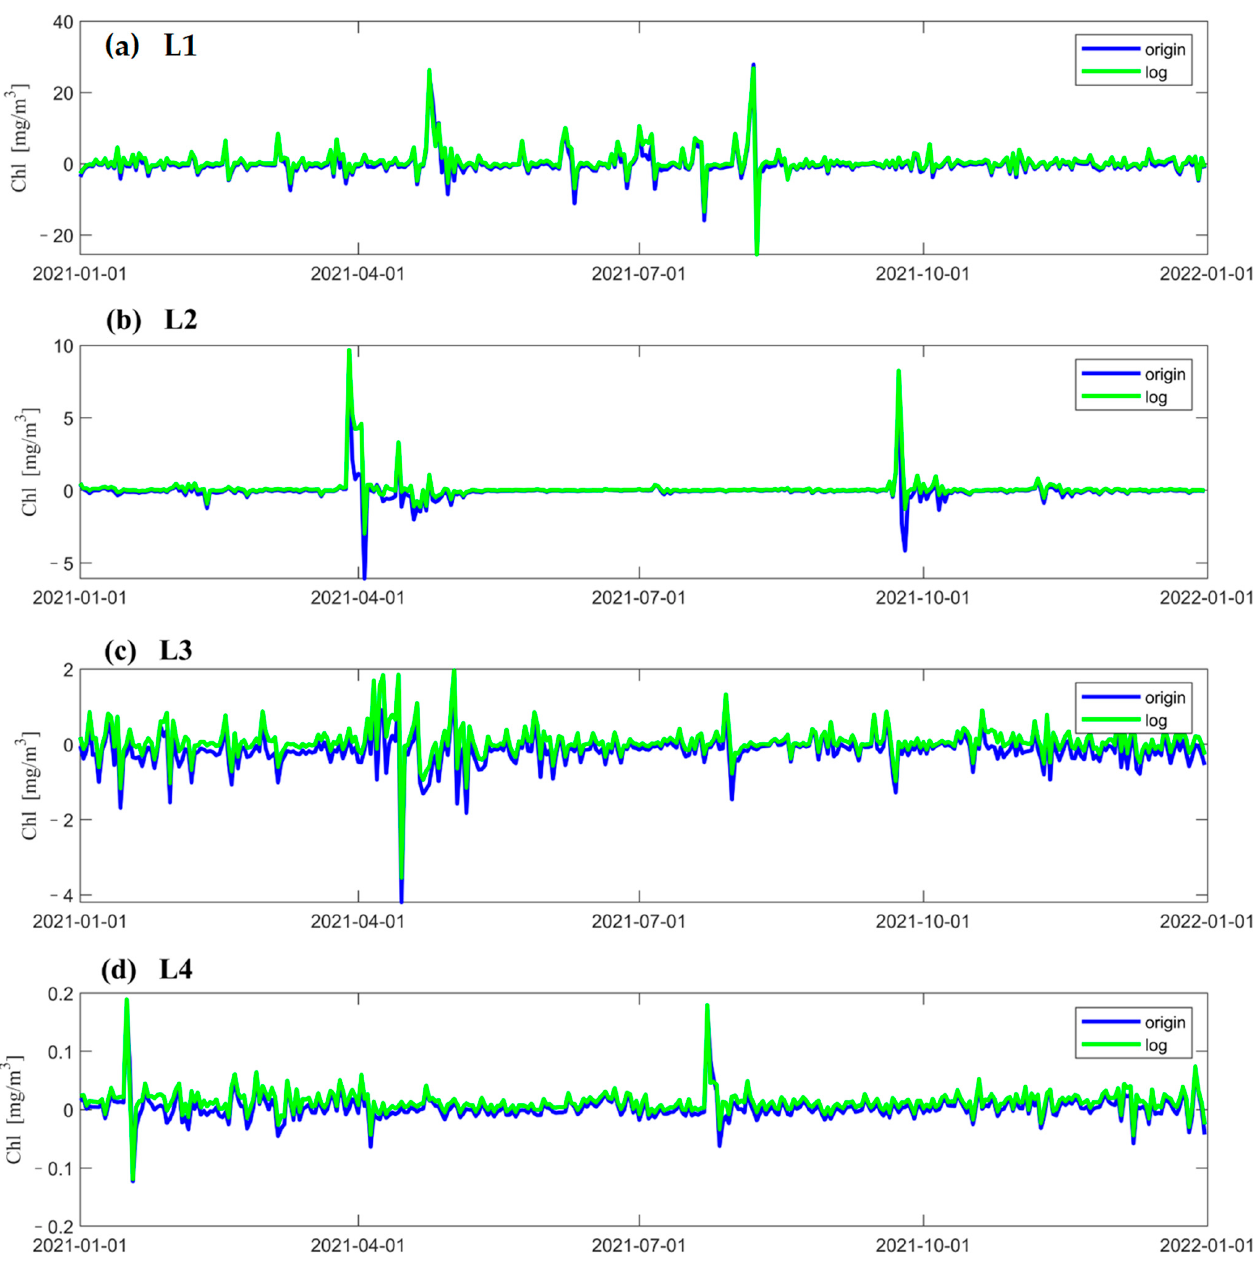
Figure 5. The error between Chl-a data from satellite observations at different points and the results predicted by LSTM models using two different data processing methods; the error is obtained by subtracting the observed value from the LSTM forecast value. ( a – d ) show the errors at the four points L1, L2, L3, and L4 in 2021. The vertical coordinate is the Chl-a concentration and the horizontal coordinate is the number of days.